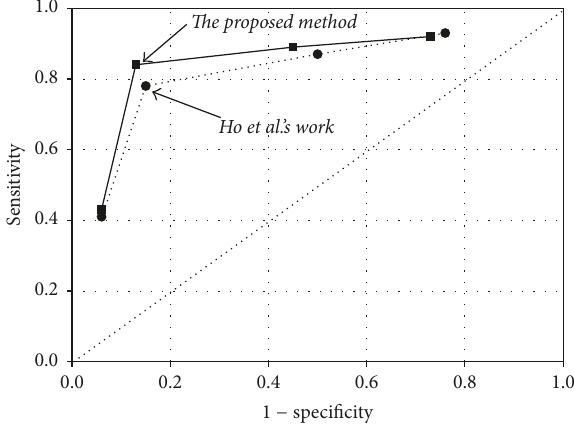
Figure 11: Comparison of two methods on receiver operating characteristic (ROC) curve.